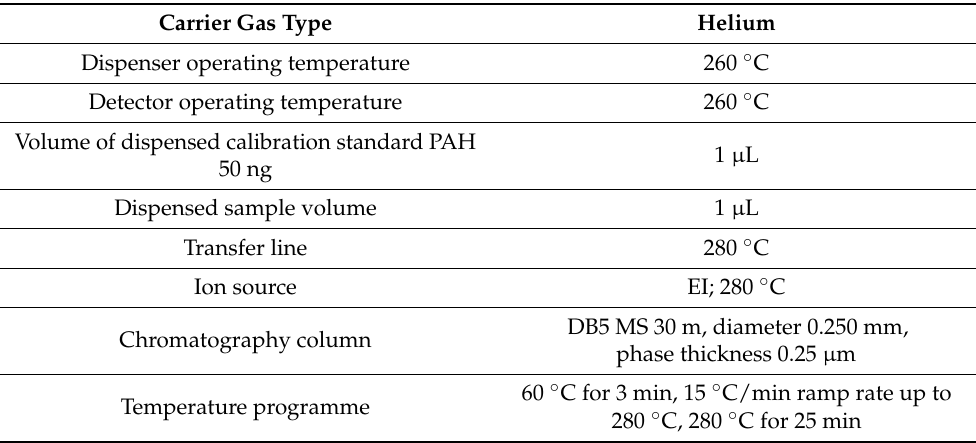
Table 8. Operating conditions of the